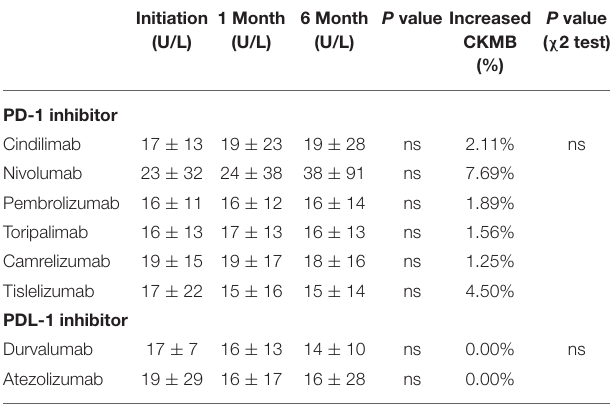
TABLE 2 | CKMB levels among paients utilizing PD-1 or PDL-1 inhibitor.